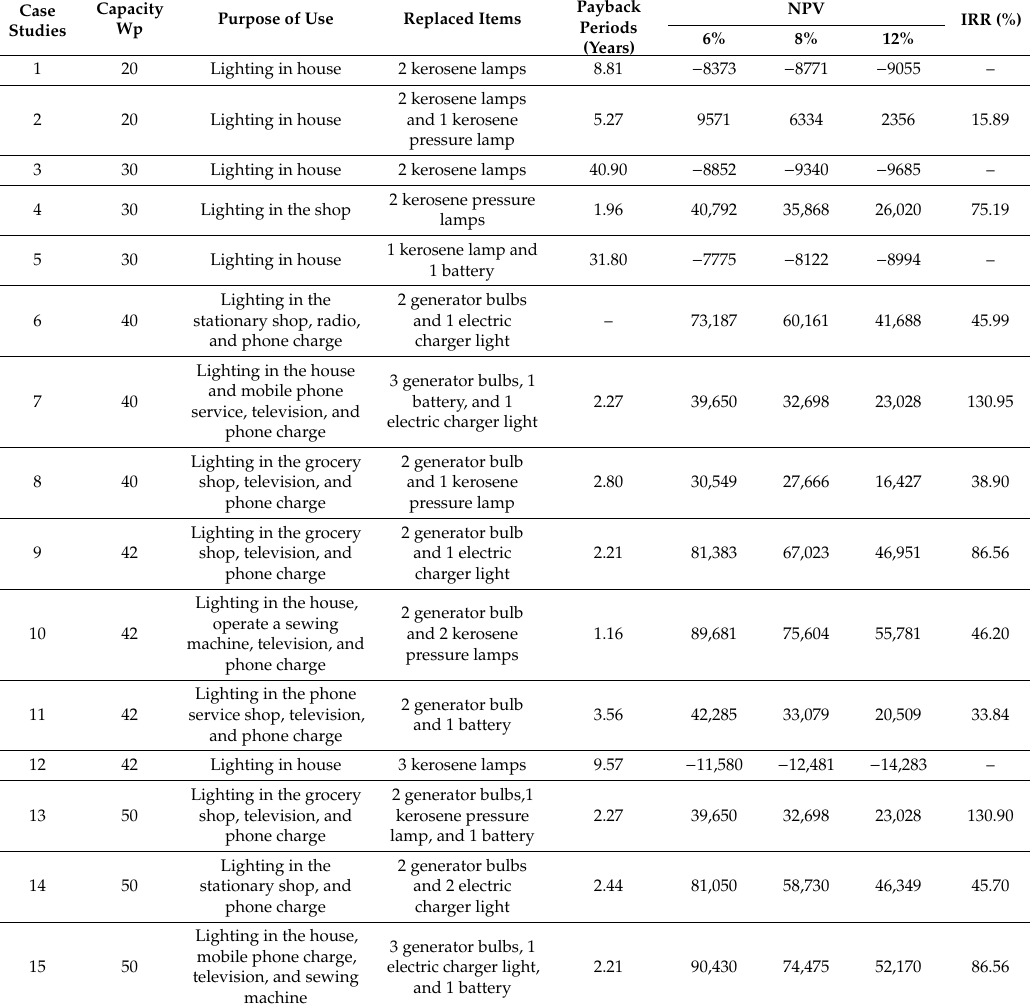
Table 5. Summary results of the financial investigation of di ff erent case